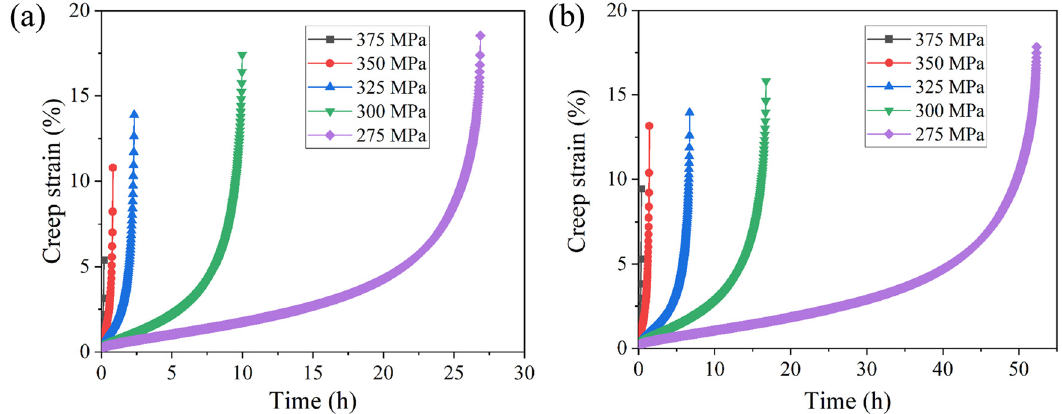
Figure 5: Creep deformation curves of the 2.25Cr1Mo0.25V steel: ( a ) BM and ( b ) WM under various stresses.